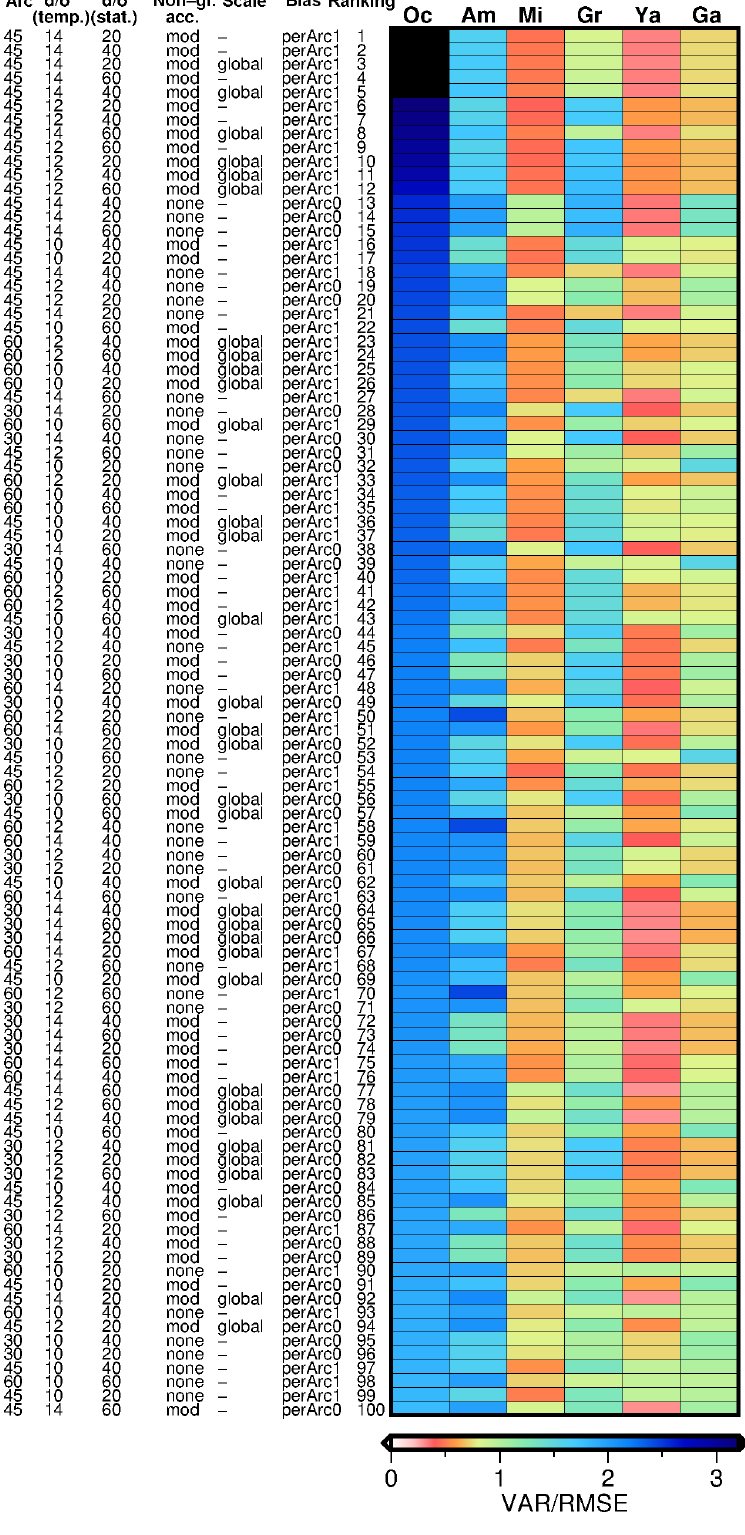
Figure 10. Evaluation of methods (CTAS